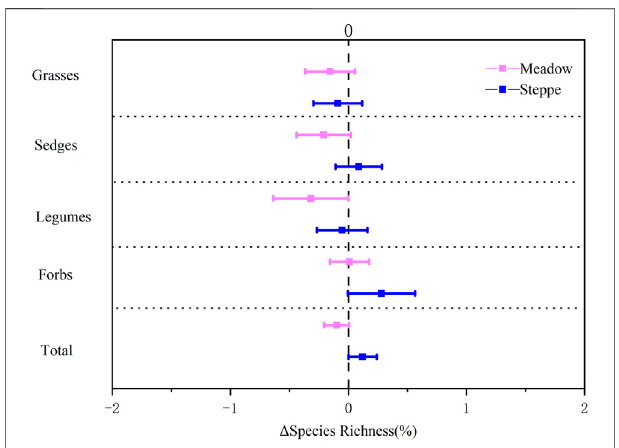
FIGURE 3 | Change in species richness of grasses, sedges, legumes, forbs, and all species in alpine meadow (red) and steppe (blue) from 2008 to 2018 in the permafrost region of the Tibetan Plateau. Relative change rate in the number of species ( Δ Species Richness) was calculated as the ratio of the absolute change (in units of species m − 2 ) to the mean species richness over the study period. Data are shown as estimate ±95% con fi dence intervals (CI). Data greater than zero represent a signi fi cant increase in the measured variable, and data lower than zero represent a signi fi cant decrease between 2008 and 2018.